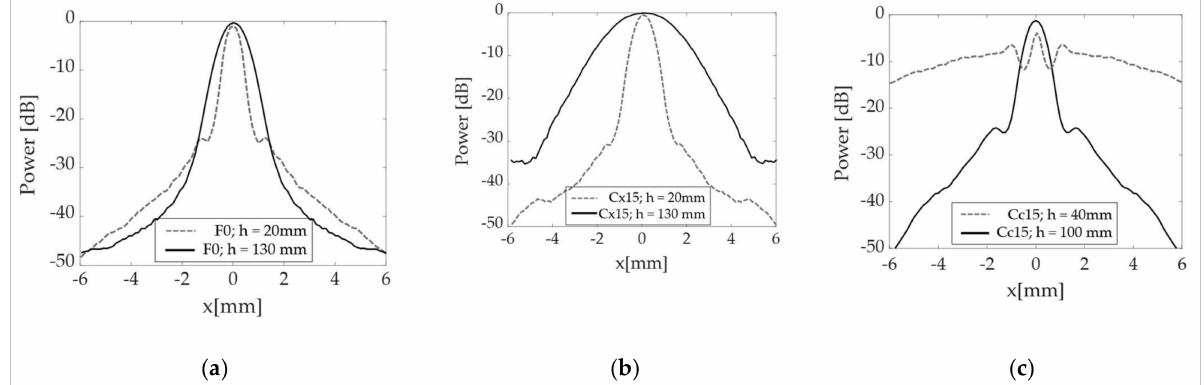
Figure 6. PSF(x) calculated for a target positioned 10 mm deep inside the parts: ( a ) Flat specimen F0 at two probe standoffs h = 20 and 130 mm; ( b ) Convex specimen Cx15 at two probe standoffs h = 20 and 130 mm; ( c ) Concave specimen Cc15 at two probe standoffs h = 40 and 100